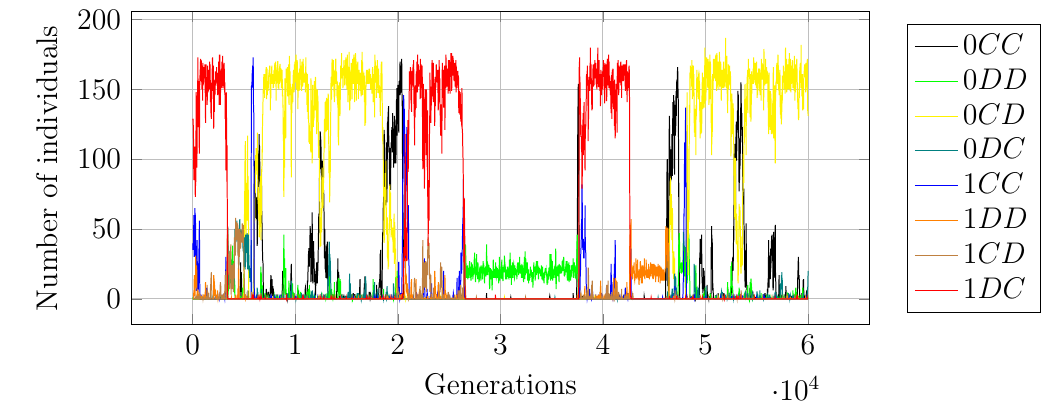
Figure 4: Time series for simulation run showing all eight strategies, c = 0.01, ρ =